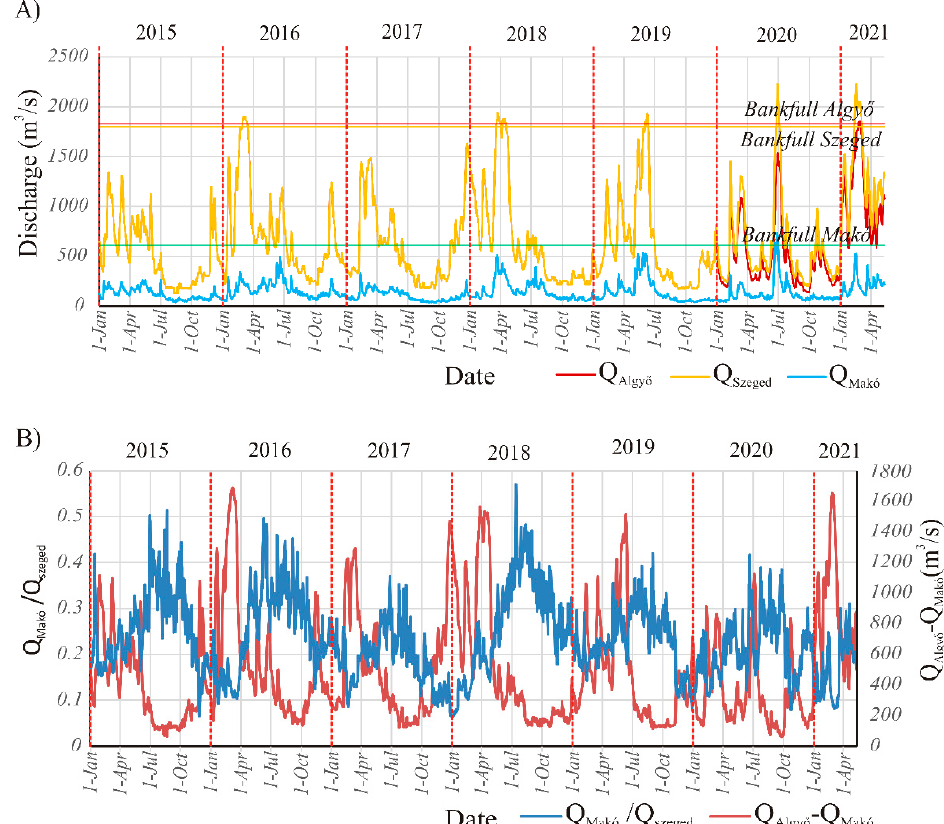
Figure 3. ( A ) Daily discharge values at the three gauging stations and ( B ) the discharge